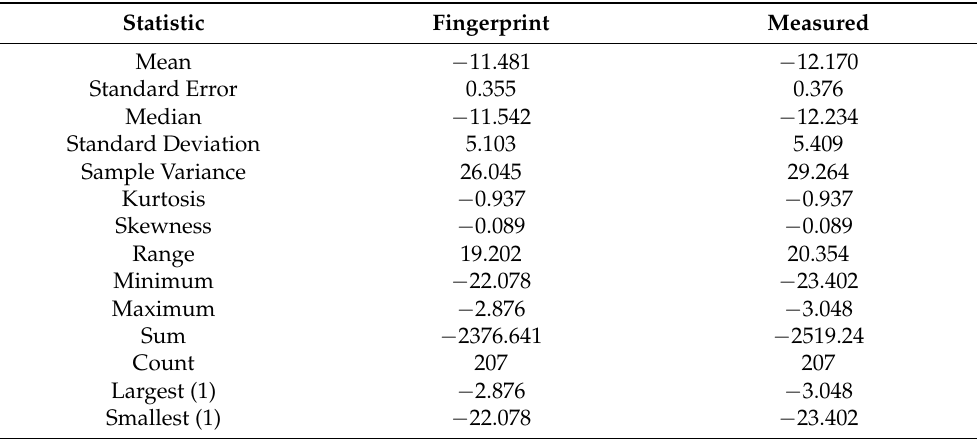
Table 10. Sub-region 2: Descriptive statistics comparison between fingerprint and measured FRA